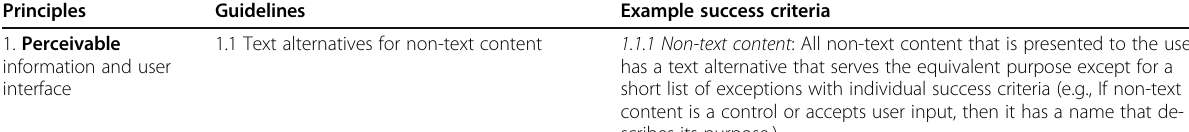
Table 5 Web Content Accessibility Guidelines (WCAG) principles, guidelines, and examples of success criteria and their levels (Note: this is not an exhaustive